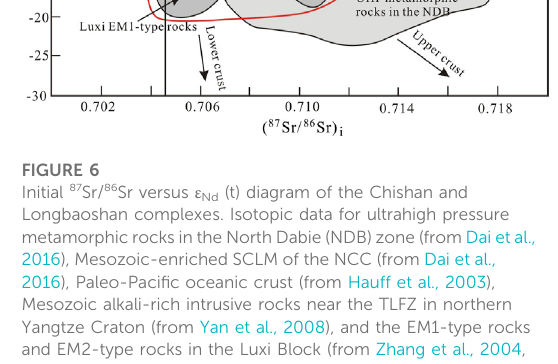
(mean = 2.09 Ga). In total, fi ve zircon grains from sample LBS-01 yield ε Hf (t) values of − 17.9 to − 13.8 (mean = − 15.4) and T DM C of 2.06 – 2.32 Ga (mean = 2.16 Ga).